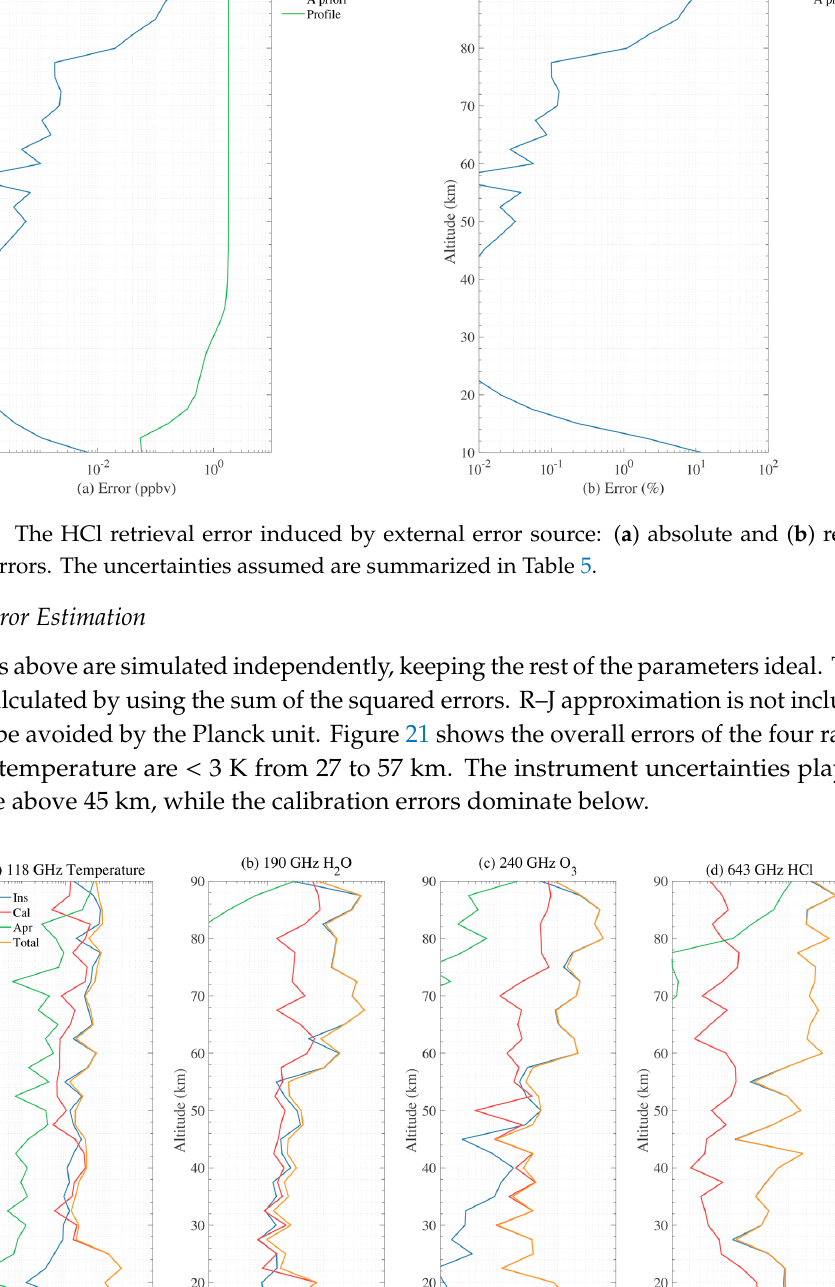
Figure 19. The HCl retrieval errors induced by different calibration error sources: ( a ) absolute and ( b ) relative retrieval errors. The uncertainties assumed are summarized in Table 4.